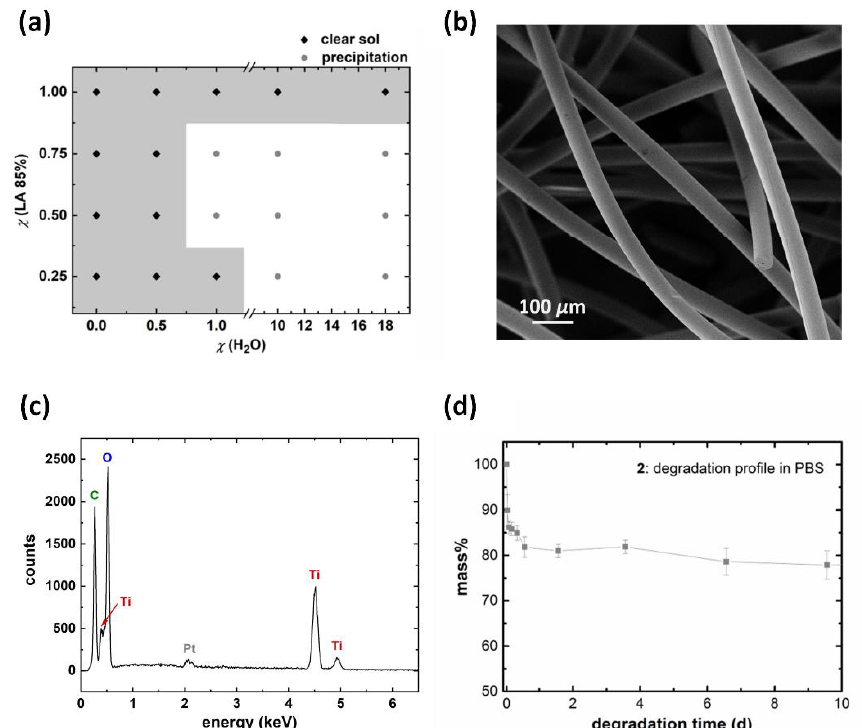
Figure 3. Variation of the LA and water ratio in sol resulted in clear spinnable sols (black rhombs) or colorless precipitates (grey circles) ( a ); SEM image of 2 assembled into a non-woven fleece ( b ); the EDX spectra of as-spun 2 ( c ) and a mass degradation profile of 2 in PBS over a period of 10 days. After an initial burst release the fibers hardly degrade ( d ).